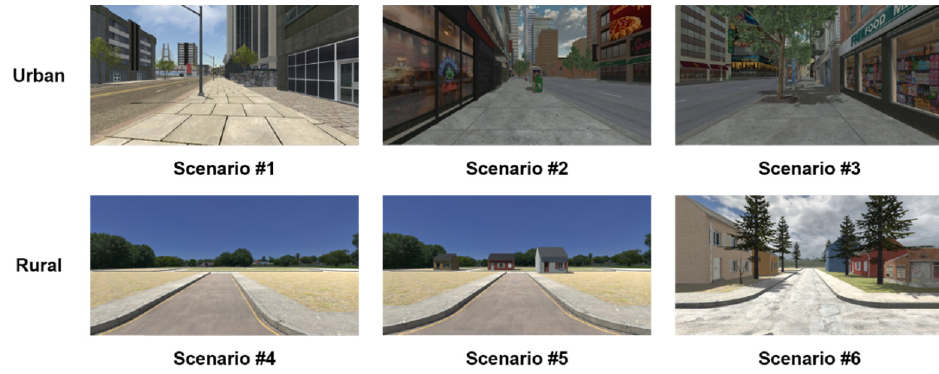
Figure 8. Six experimental scenarios (three urban environments and three rural landscapes).